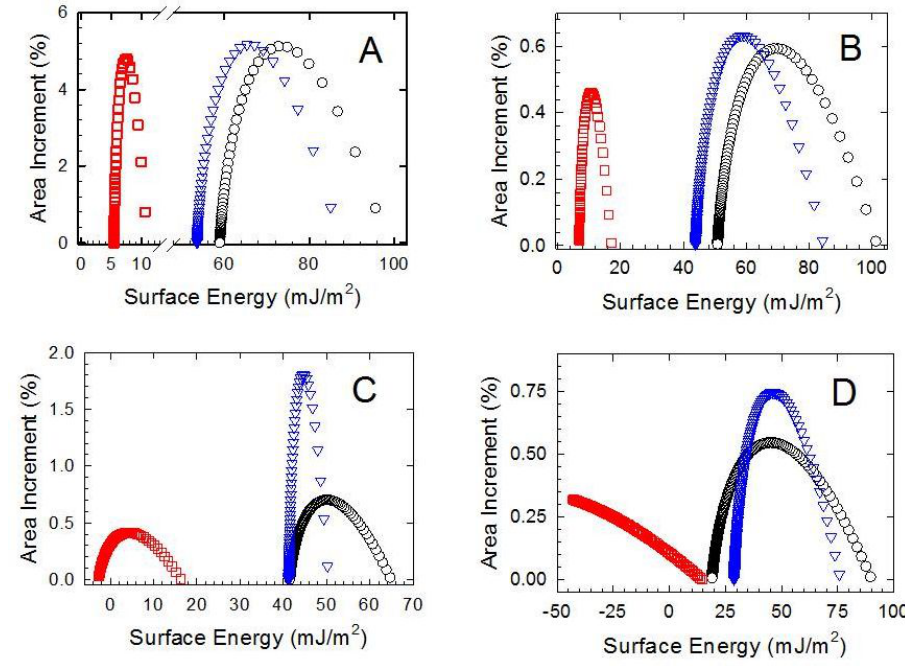
Figure 2: Surface energy distribution of studied fillers: A – calcium carbonate hollow spheres (sample 1), B – mica (sample 2), C – wollas- tonite (sample 3), D – perlite (sample 4). Square – polar part of the surface energy, triangle – dispersive part and circle – total surface energy